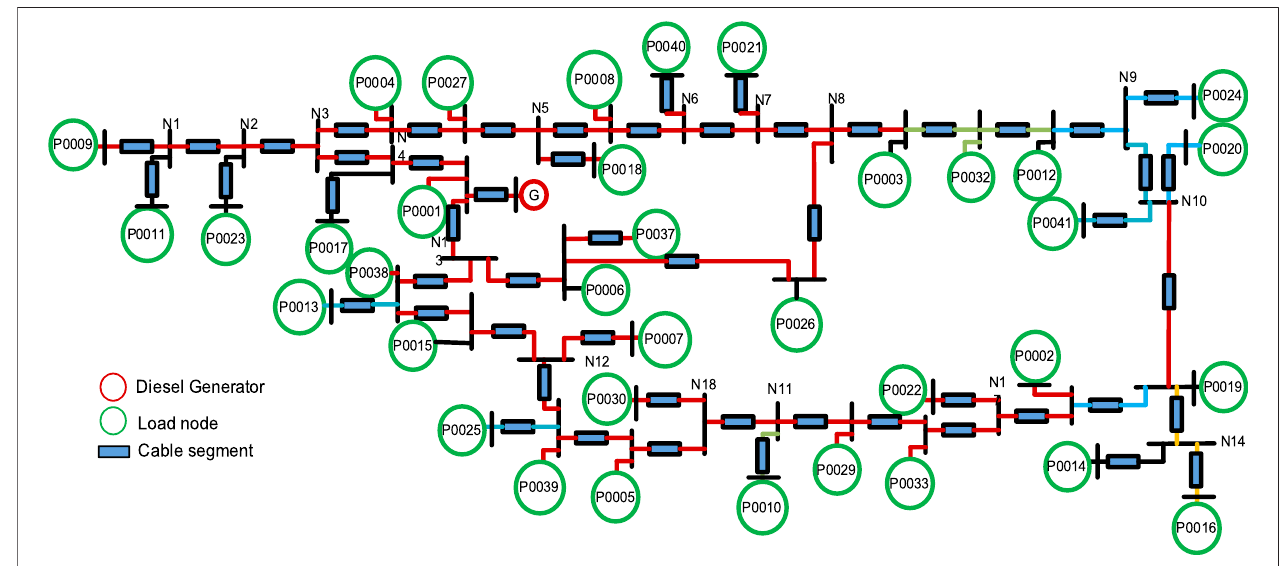
FIGURE 6 | Schematic of the power network for the island of Ushant where P refers to the load number and N refers to the node number.